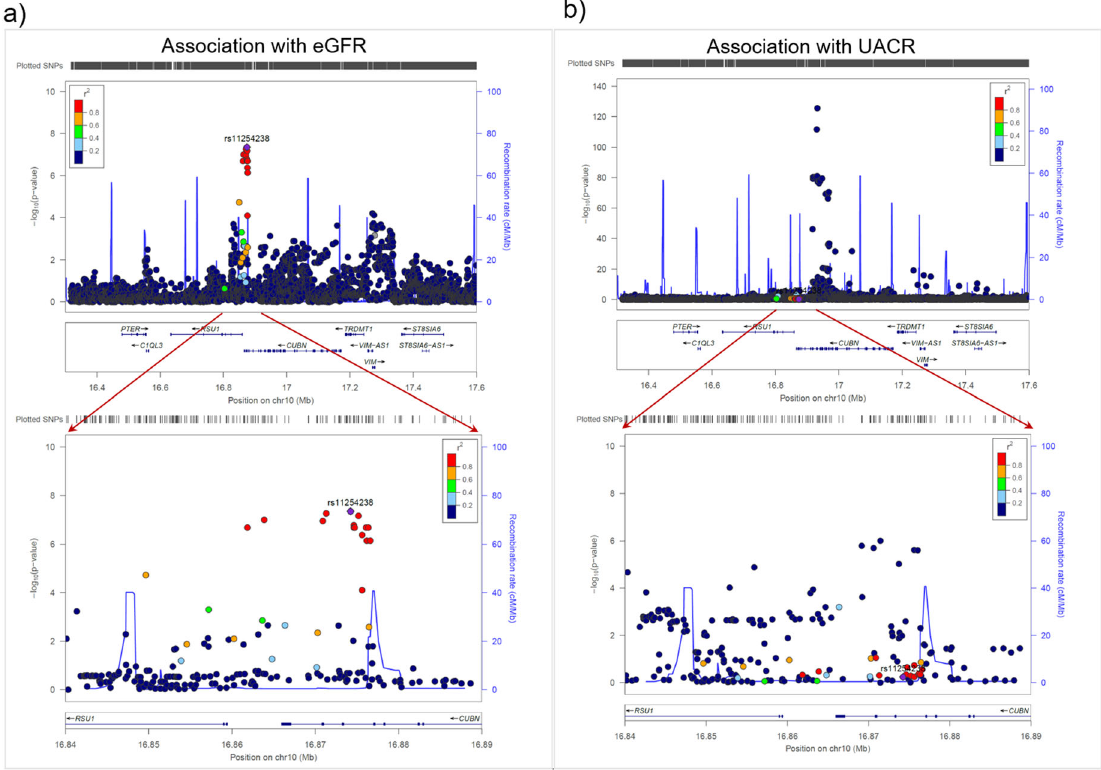
Fig. 4 The variants associated with eGFR in the CUBN locus differ from those associated with urinary albumin-to-creatinine ratio. Shown are P -values for associations at the wider (top) and more narrow (bottom) CUBN locus region for a eGFR (joint test P -values, n DM = 178,691 and n noDM = 1,296,113) and b urinary albumin-to-creatinine ratio (UACR; P -values from ref. 39 , n = 564,257). Lead variant for eGFR is rs11254238; color codes variants ’ correlation r 2 to rs11254238 in all